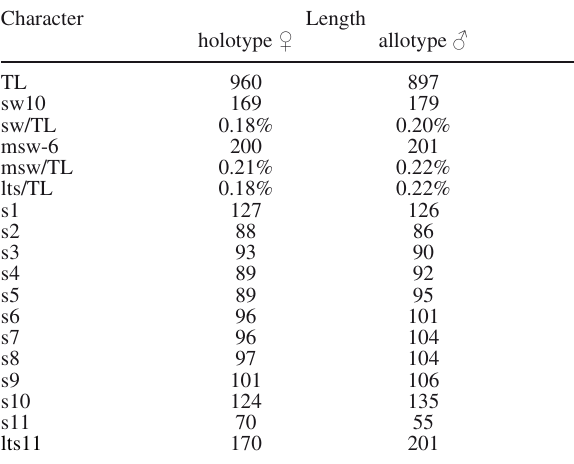
(Fig. 15D); pore surrounded by few short hairs (Fig. 14K). Sternal plates similar to those on previous seg- ments but with one additional pair of ventromedial cuticular ridges, ventromedial setae and ventrolateral sensory spots (Figs 14M, 15D). One pair of apodemes present near anterior margin of segment, visible in both sexes (Fig. 12A). Patches of cuticular hairs on both dorsal and ventral side similar to those on segment 5. Peg and socket joints inconspicuous. Otherwise similar to preceding segment.